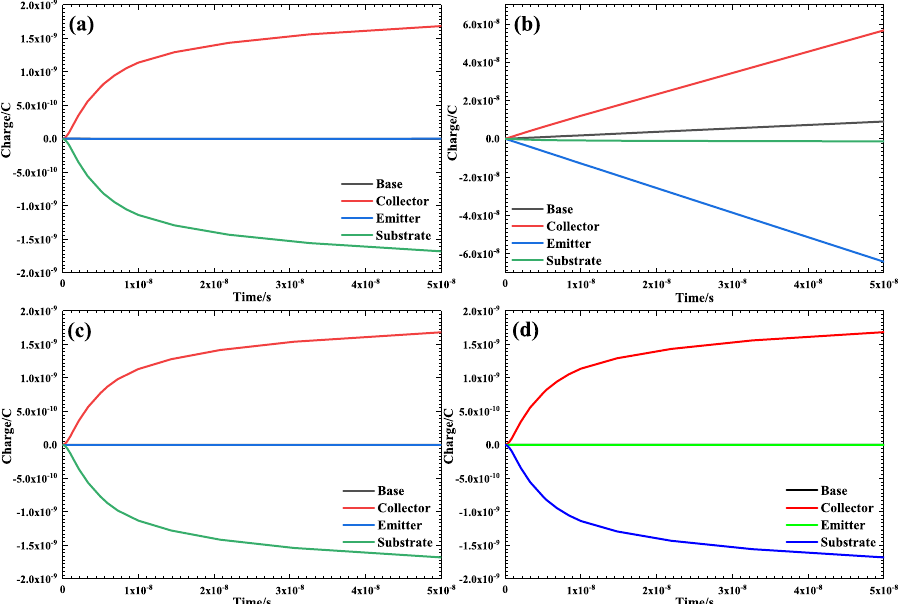
Figure A5. Change in collected charge with time when heavy ions vertically irradiate the emitter of the SiGe HBT under the substrate inverse bias ( a ), positive bias ( b ), off bias ( c ) and collector positive bias ( d ) states.